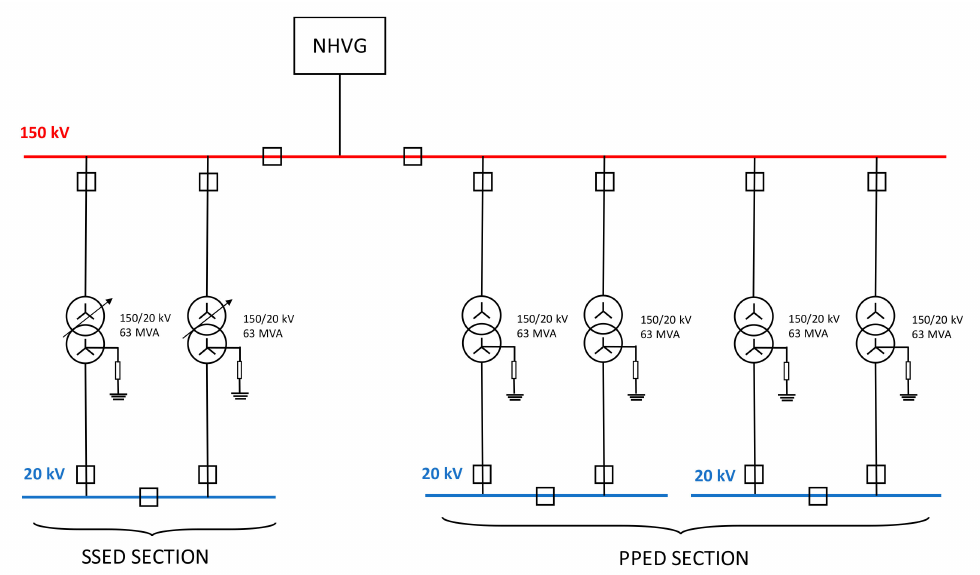
Figure 2. Scheme of the DTT HV/MV substation